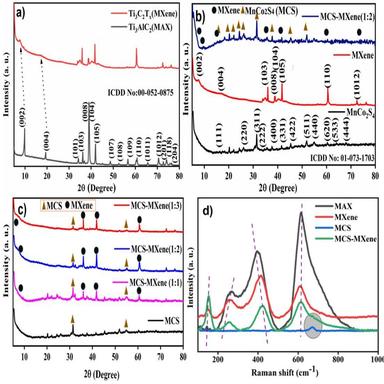
XRD patterns of (a) MAX phase and MXene; (b) MCS, MXene, MCS-MXene hybrid; (c) MCS, MCS-MXene (1:1), (1:2), (1:3) compositions; (d) Raman spectra of MAX, MXene, MCS, MCS-MXene (1:2).